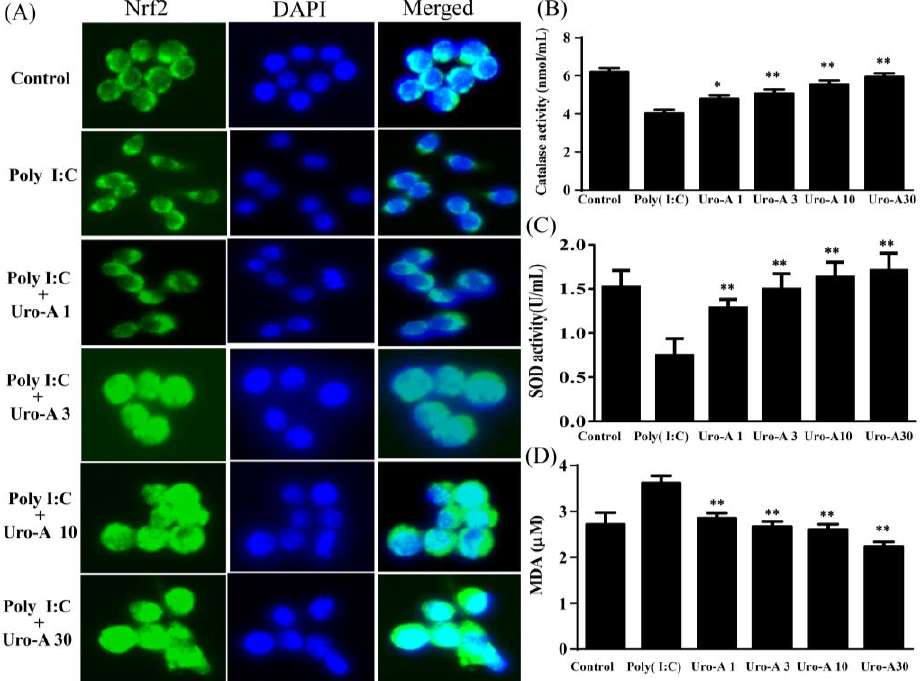
Figure 7. Urolithin A (Uro-A) activated Nrf2 expression and enhanced antioxidant defense in poly(I:C)-stimulated RAW264.7 cells. ( A ) Uro-A promoted Nrf2 (green) translocation from the cytoplasm into the nucleus (DAPI, blue). ( B ) Uro-A increased the activities of antioxidant enzymes SOD and ( C ) CAT, and ( D ) attenuated MDA production. RAW264.7 cells were pre-cultured with different concentrations of Uro-A for 1 h, and then incubated with poly(I:C) (1 ng/mL) for 24 h. Data are presented as mean ± SD. * p < 0.05, ** p < 0.01 compared to RAW264.7 cells stimulated with poly(I:C) alone.